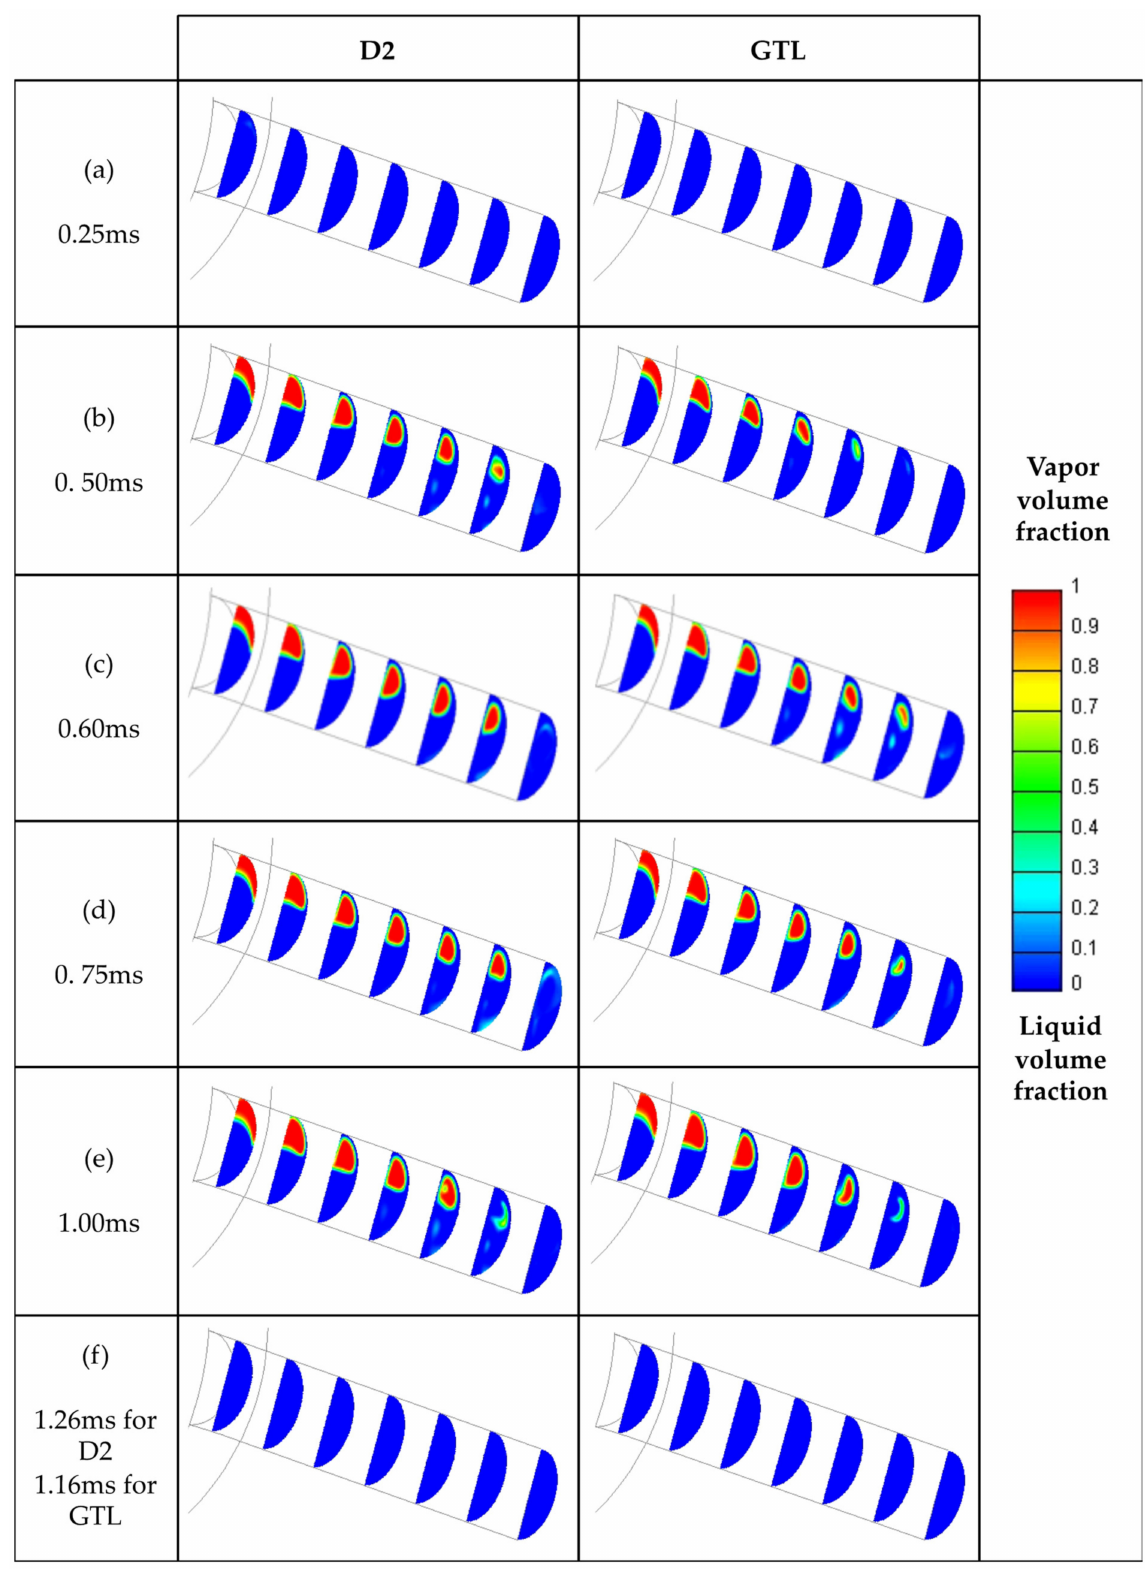
Figure 11. Vapor Volume Fraction at 40 bar of in-cylinder